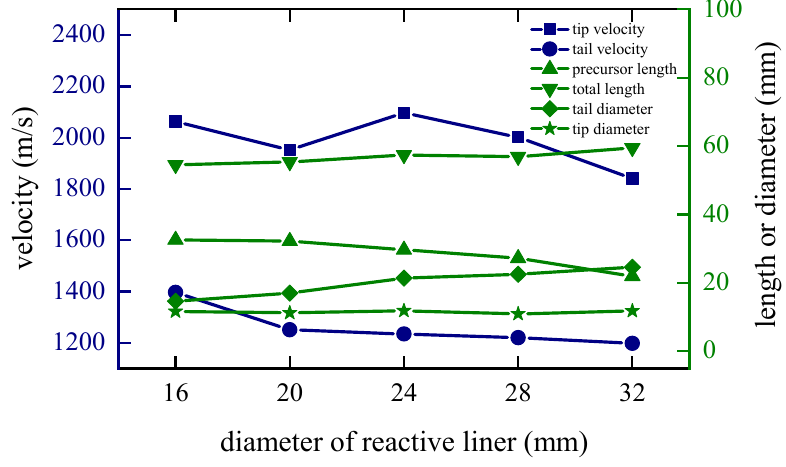
Figure 17. Curves of coating EFP shape parameter change.